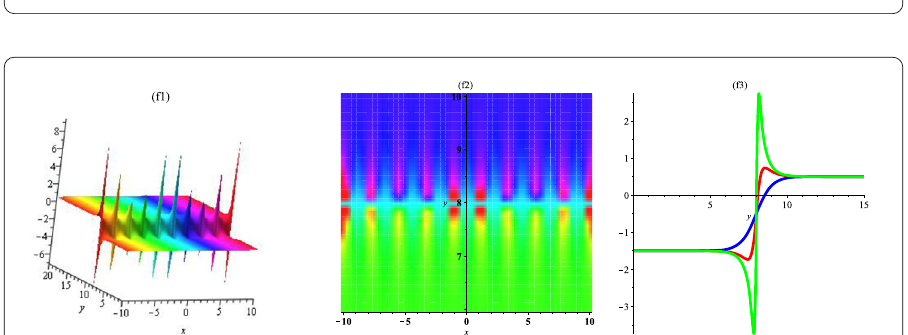
Figure 6 For solution of (2) w , c i = 1, t = 1, z = 20, (f1) 3D plot (f2) density plot and (f3) 2D plot with spaces x = –3,0,3